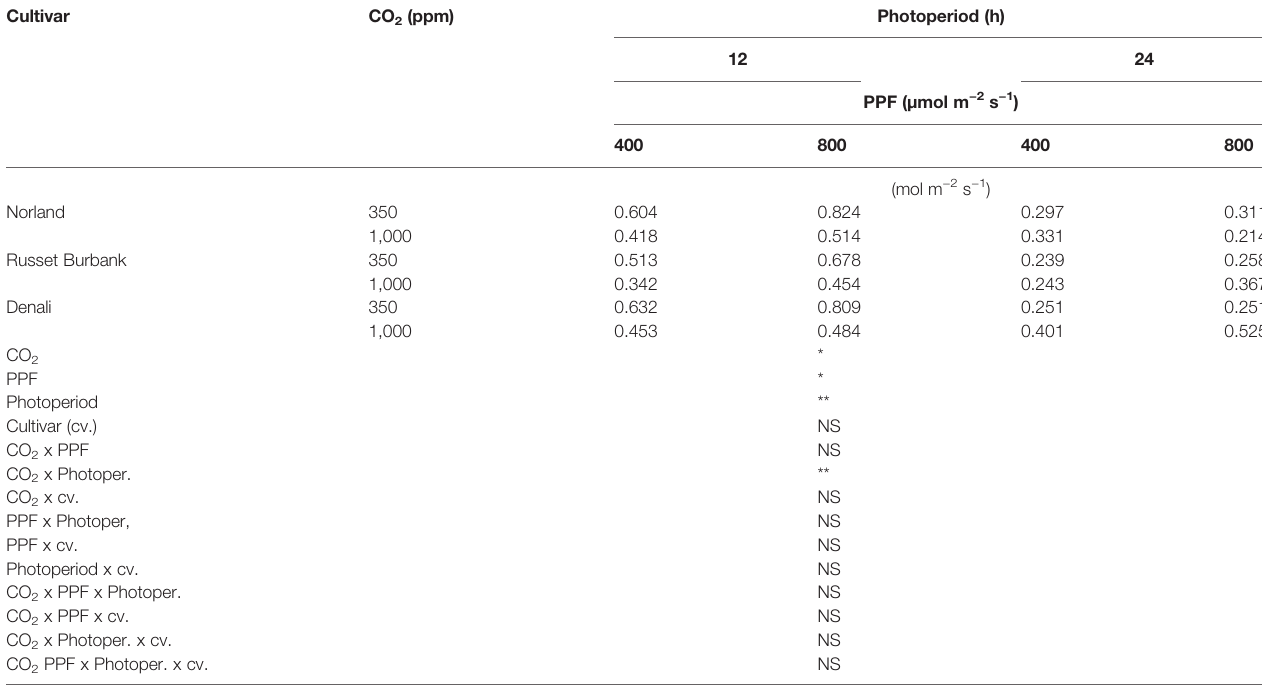
TABLE 3 | Stomatal conductance rates of potato leaves under different photoperiods, CO 2 , and photosynthetic photon fl ux levels (28 days after planting). Cultivar